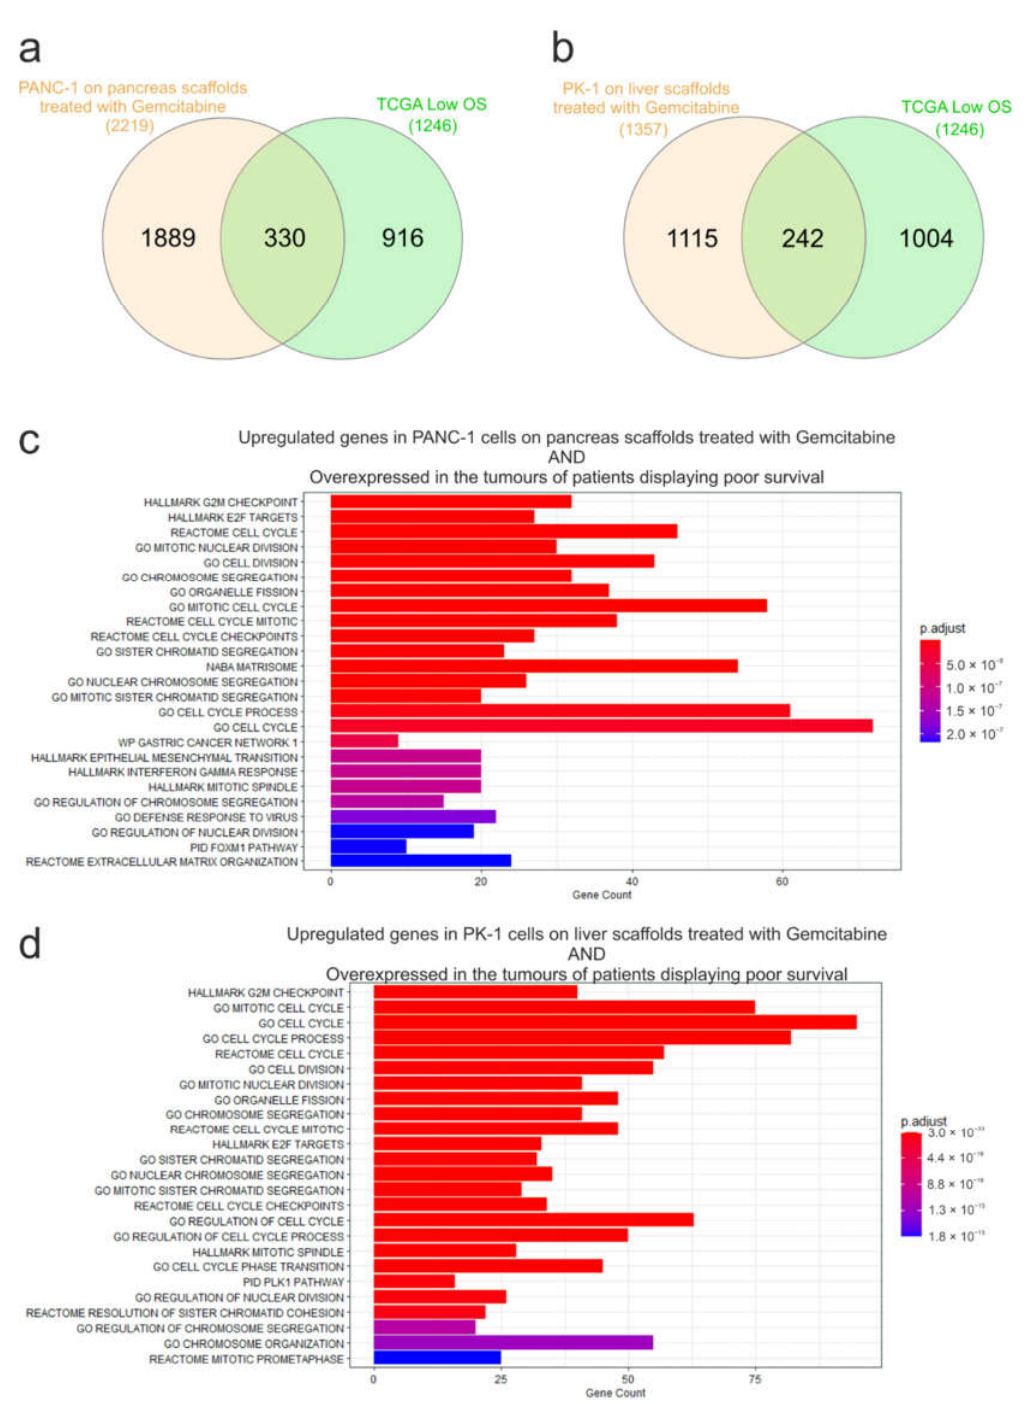
Figure 7. Overlap analysis of genes significantly induced by gemcitabine treatment and genes associated with low overall survival in pancreatic cancer patients. Venn diagrams to show the overlap of genes significantly overexpressed in ( a ) PANC-1 or ( b ) PK-1 cells following gemcitabine treatment and those increased in the tumours of patients displaying poor survival i.e., low overall survival (OS). Functional analysis of the genes identified in ( c ) PANC-1 and ( d ) PK-1 cells treated with gemcitabine and also found to be overexpressed in the tumours of patients displaying poor